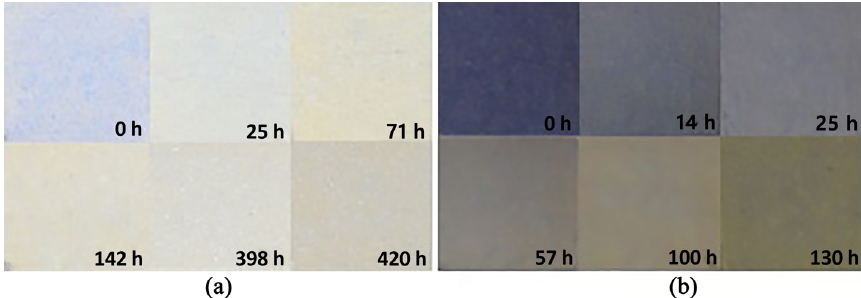
) under (a) UVC and (b) sunlight. 2